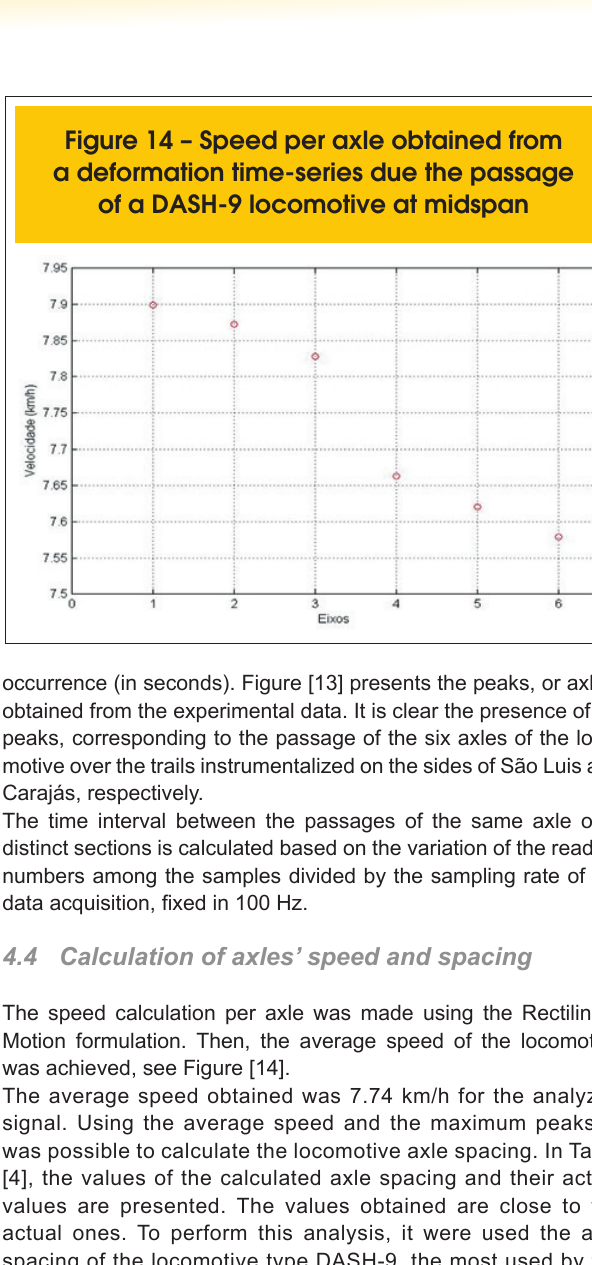
Figure 15 – Idealized Stress-strain diagram (ABNT NBR 6118